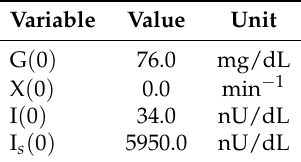
Figure 5. Simulations of the OGTT at PND26 for the control group, Cd1 and Cd2 groups. Table 7. Initial condition determined for the control group and groups Cd1 and Cd2 at PND26.